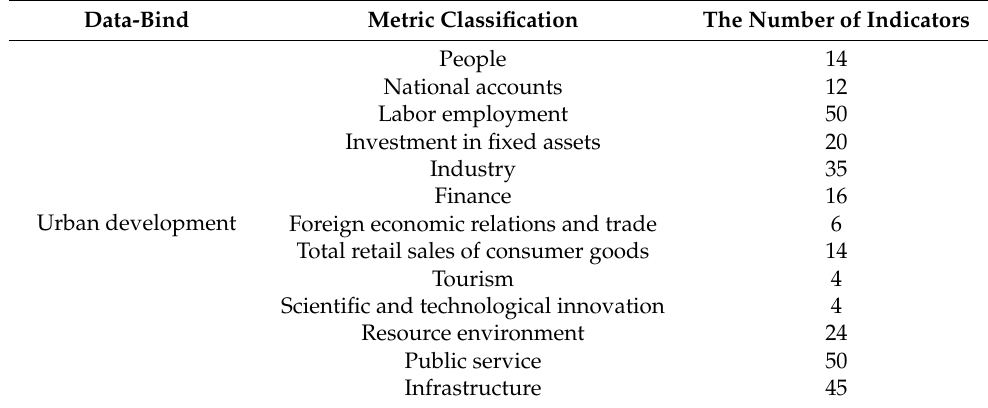
Table A1. Crawling results of